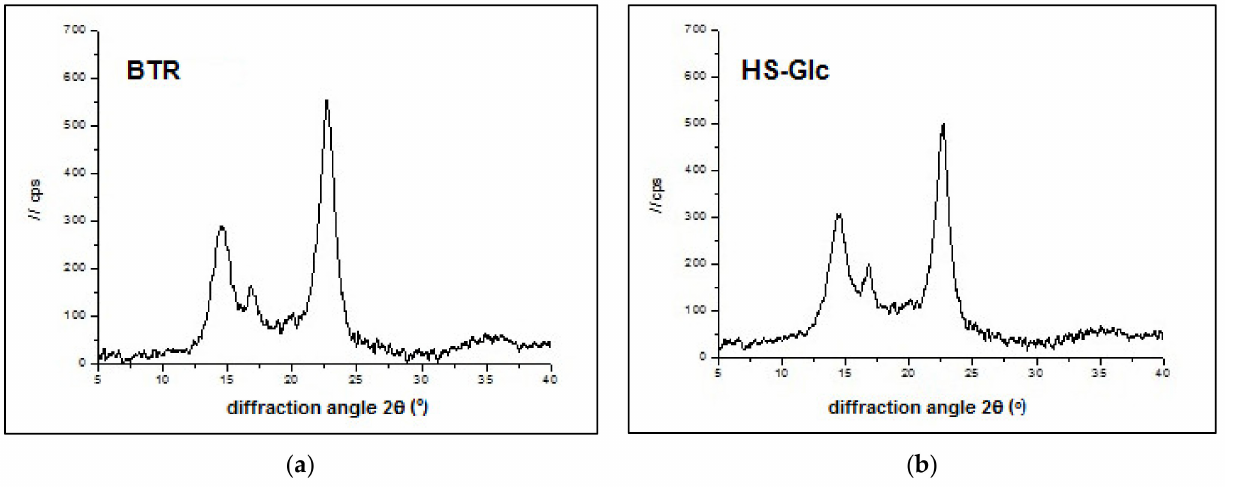
Figure 8. X-ray diffraction spectra of BNC produced in different culture media: ( a ) beetroot and ( b ) modified HS medium with glucose as the sole carbon source.